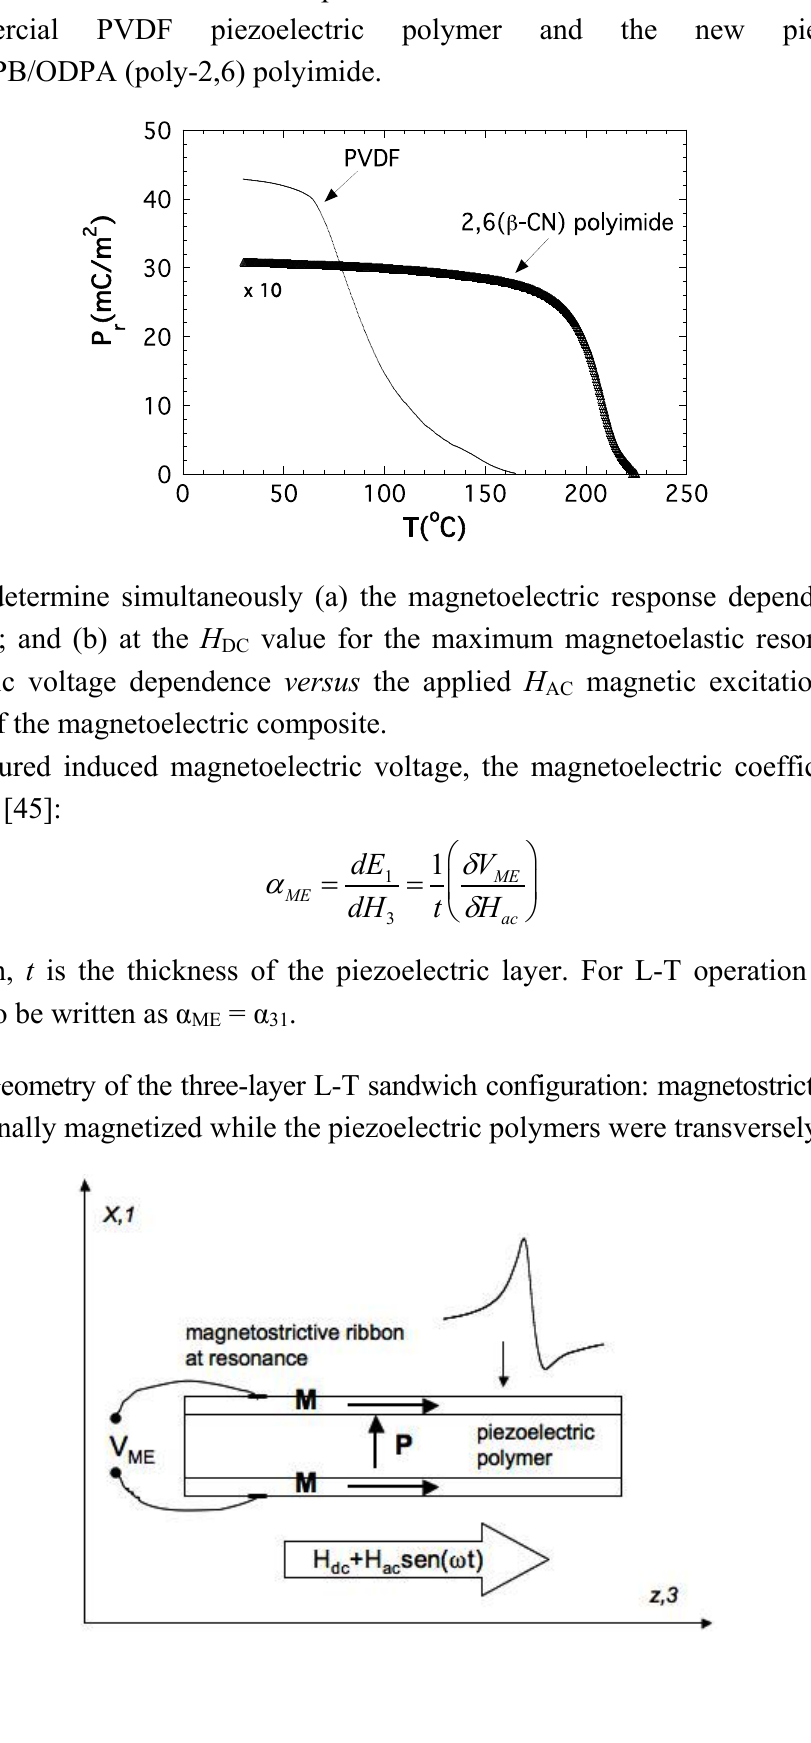
Figure 12. Measured remnant polarization as a function of temperature for commercial PVDF piezoelectric polymer and the new piezolelectric